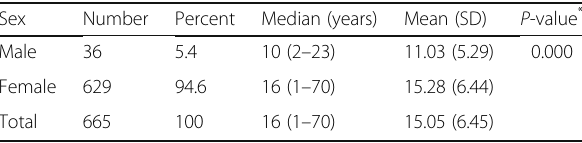
Table 1 Age comparison between male and female cases of sexual violence in Pekanbaru, Indonesia ( n = 665)